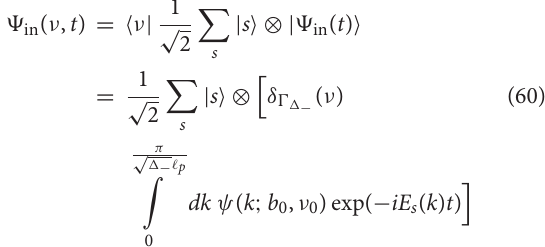
FIGURE 5 | Schematic representation of the state of interest. There are two different UV structures with dynamical implications via the state represented here has trivial correlations with the microscopic structure and would lead to a zero initial entanglement entropy state as defined by the reduced density matrix where the background state is traced